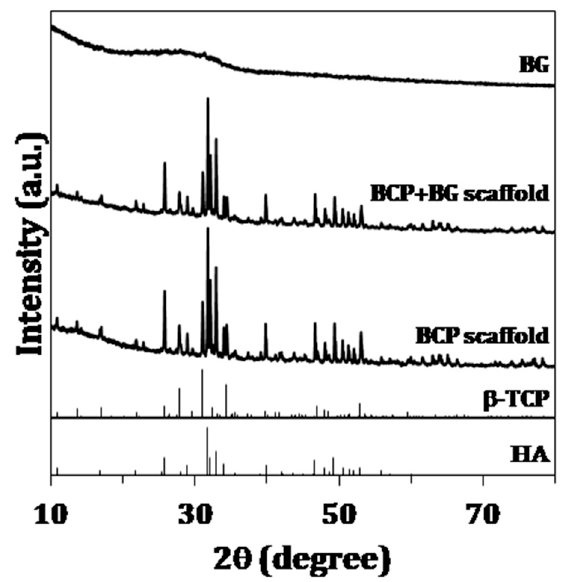
Figure 1. Sol-gel derived bioactive glasses (BG), biphasic calcium phosphates (BCP) sca ff olds and BG-coated sca ff olds. The standard di ff raction patterns of β -tricalcium phosphate ( β -TCP) and hydroxyapatite (HA) standards, ICDD PDF 04-006-9376 and 04-015-7245, respectively, are also present for comparison purposes.